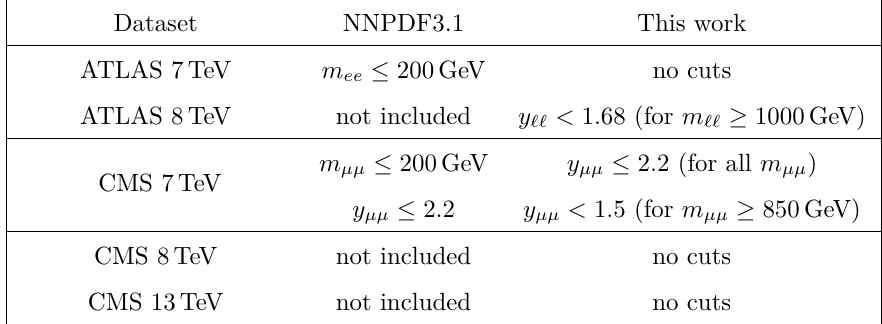
Table 9 . The kinematic cuts applied to the high-mass Drell-Yan datasets listed in table 2, compared to those used in